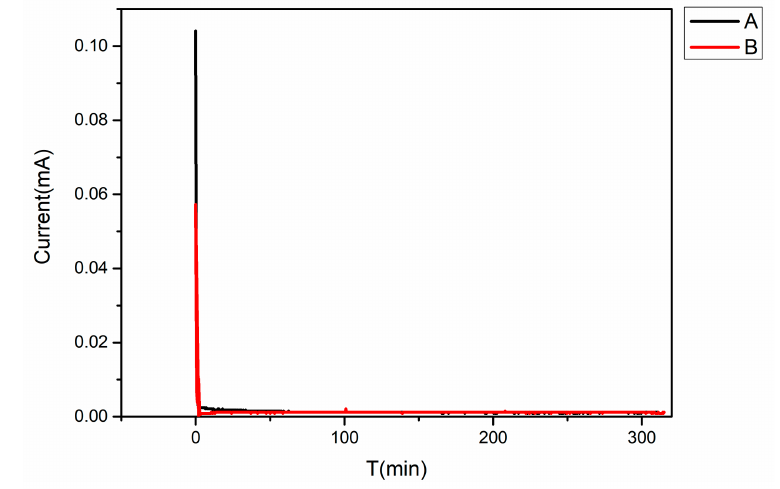
Figure 8. Direct Current (DC) polarization test results of the PEO-based solid